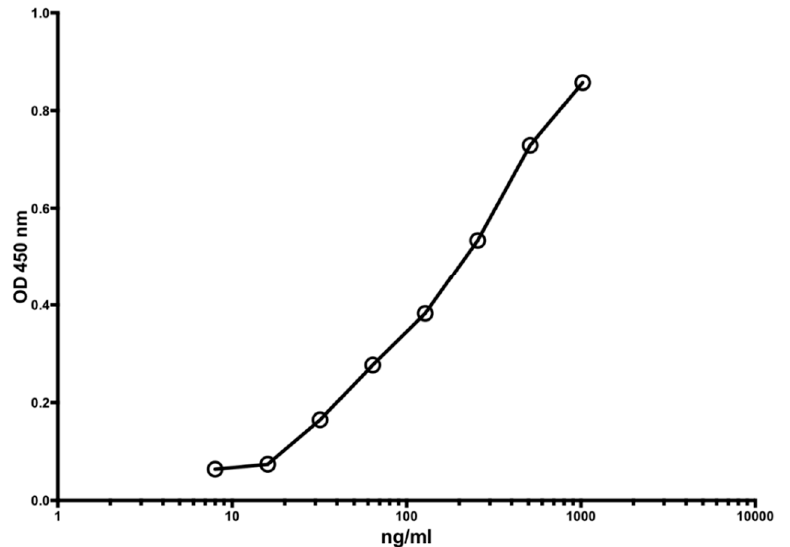
Figure 12. This shows the standard curve obtained when testing a fecal CP standard prepared by mixing of anion exchange chromatographic fractions 2 to 80, shown in Figure 3. Most of the salt was removed by dialysis and 0.1% Proclin 300 was added to prevent microbial growth. An assay range of 15 to 1000 ng/mL can be obtained.